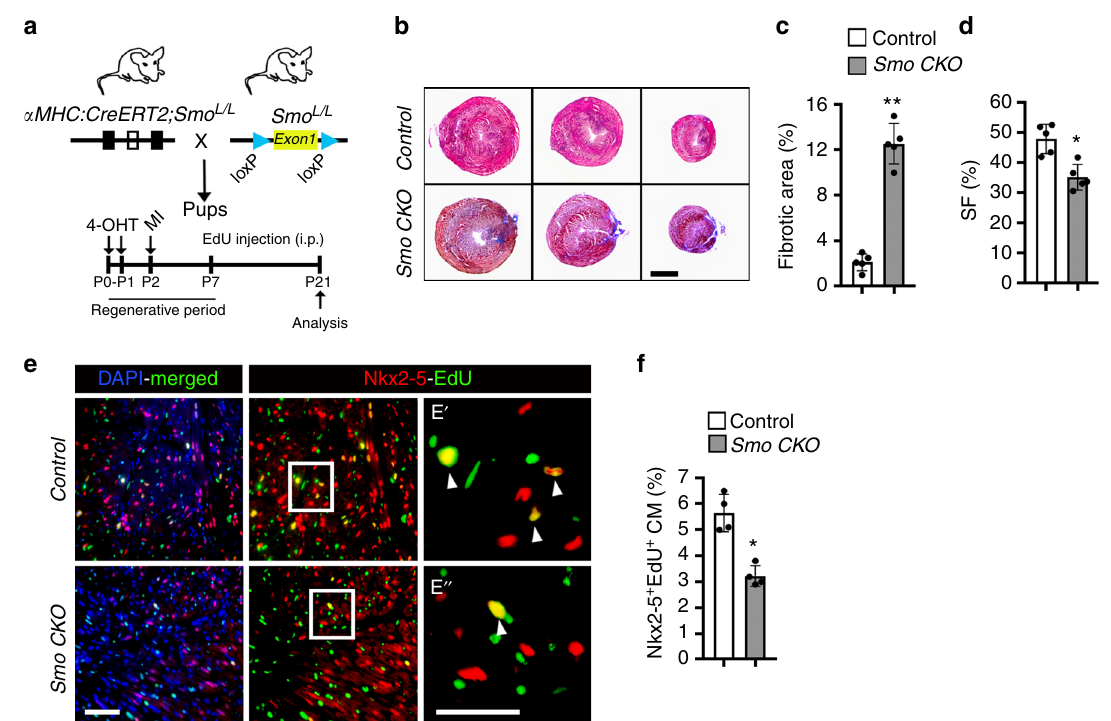
Fig. 5 Conditional deletion of Smoothened ( Smo CKO ) results in impaired neonatal heart regeneration following myocardial injury. a Schematic of cardiomyocyte-speci fi c conditional deletion of the fl oxed-Smo allele and heart regeneration analysis following MI. The MI was performed on P2. b , c Masson trichrome staining of representative sections (B) and fi brotic area quanti fi cation ( c ) of heart sections at 21 days postinjury ( n = 5 for each group). d Echocardiographic measurements (SF) of cardiac function from control and Smo CKO at 21 days post-MI ( n = 5 per group). e , f Immunostaining ( e ) and quanti fi cation ( f ) of Nkx2-5 + -EdU + cardiomyocytes from control and Smo CKO at 21 days post-MI ( n = 4 per group). The boxed region in the middle panel of “ e ” is magni fi ed in panels E ′ and E ″ . Arrowheads indicate EdU + cardiomyocytes. Quantitative analysis represents counting of three random fi elds at 20× magni fi cation from four biological replicates in each group. Data are presented as mean ± SEM (* p < 0.05, ** p < 0.01) and scale bars = 100 μ m. Statistical tests were done using two-tailed unpaired Student ’ s t